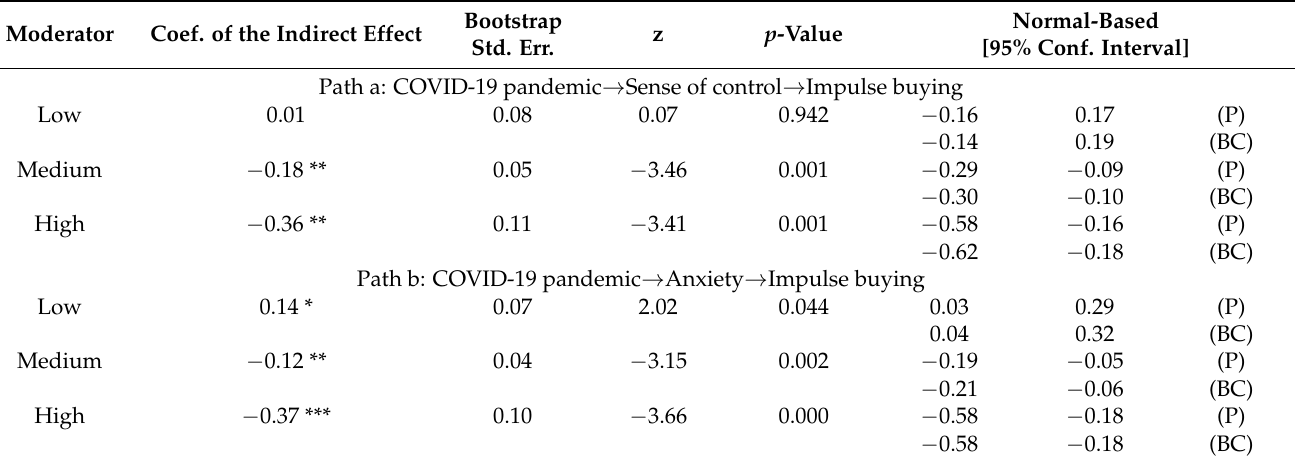
Table 2. Moderated-mediation test